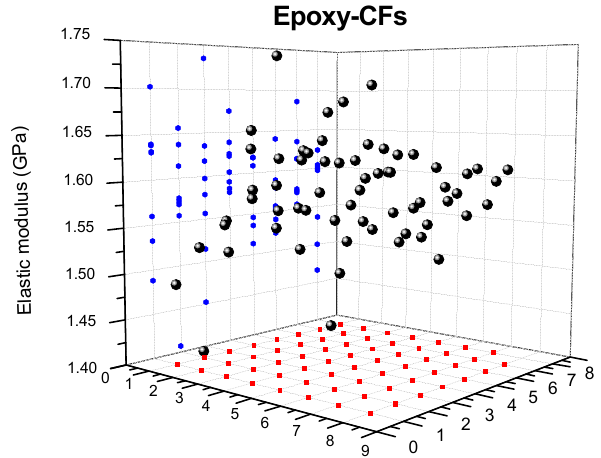
Figure 8. Elastic modulus obtained from the loading ‐ unloading mapping measurements at 200 nm of displacement for the epoxy ‐ CFs sample.